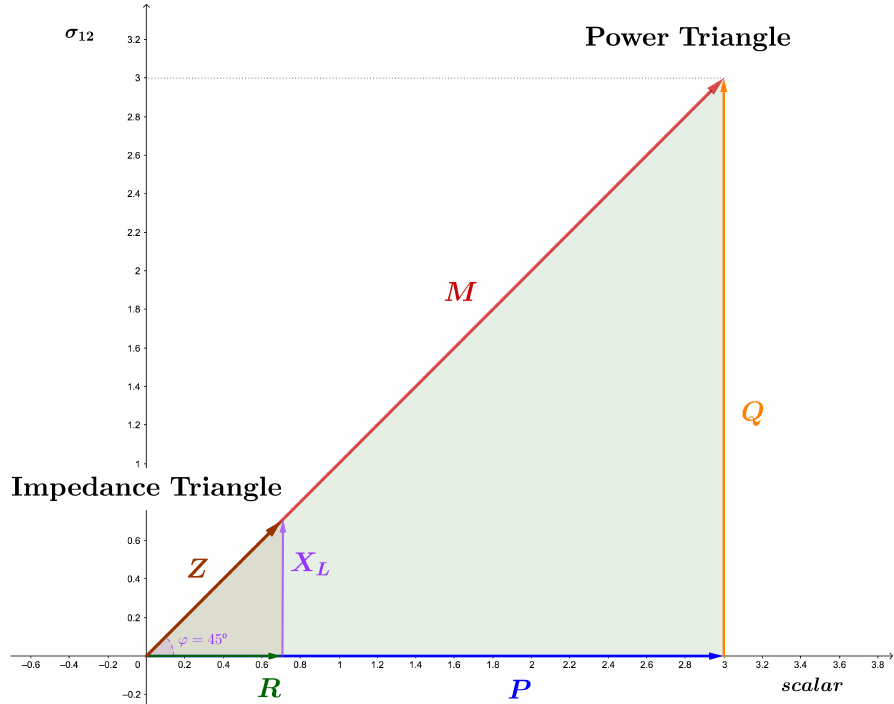
Figure 4. Power and impedance triangle in GA plane scalar - σ 12